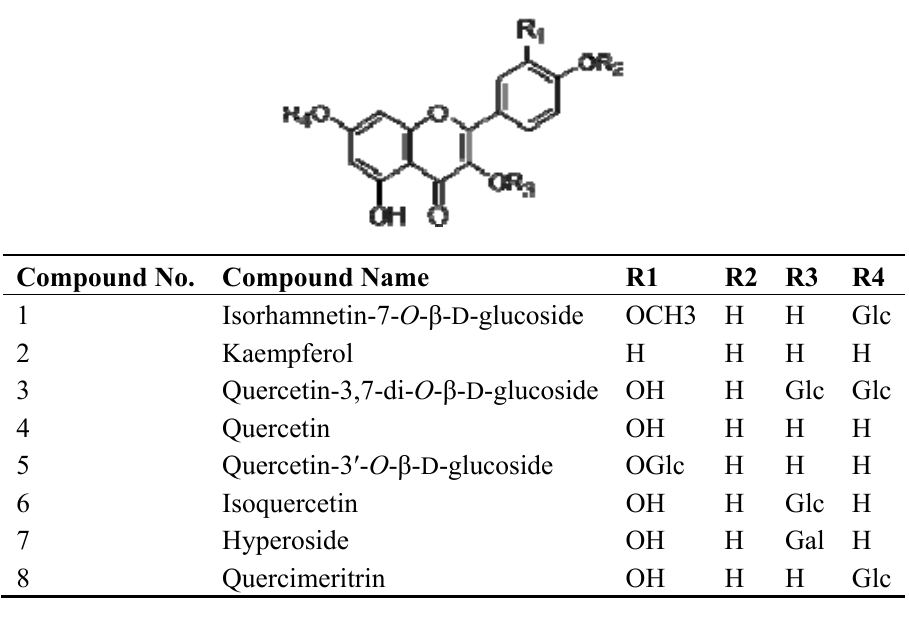
Figure 2. Chemical structures of the compounds from GHE.